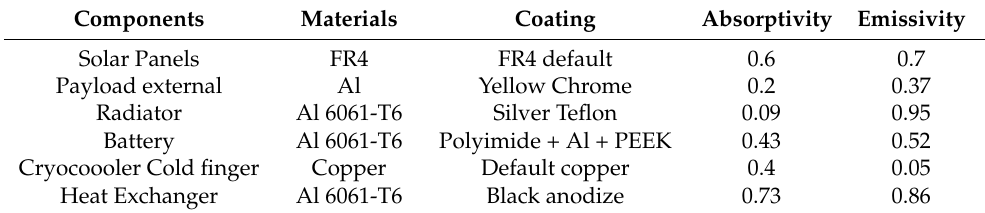
Table 5. Surface properties—Used.